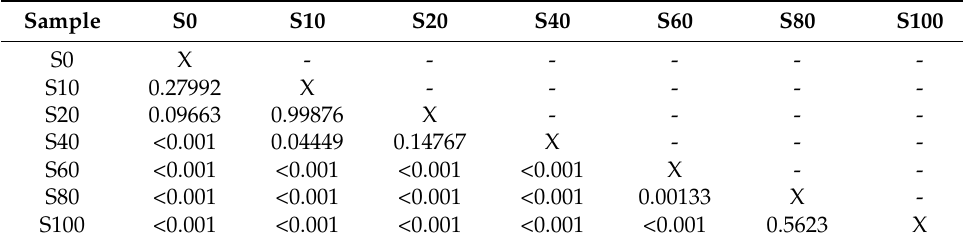
Table A2. Post-hoc analysis by Tukey’s test of the ϕ values.